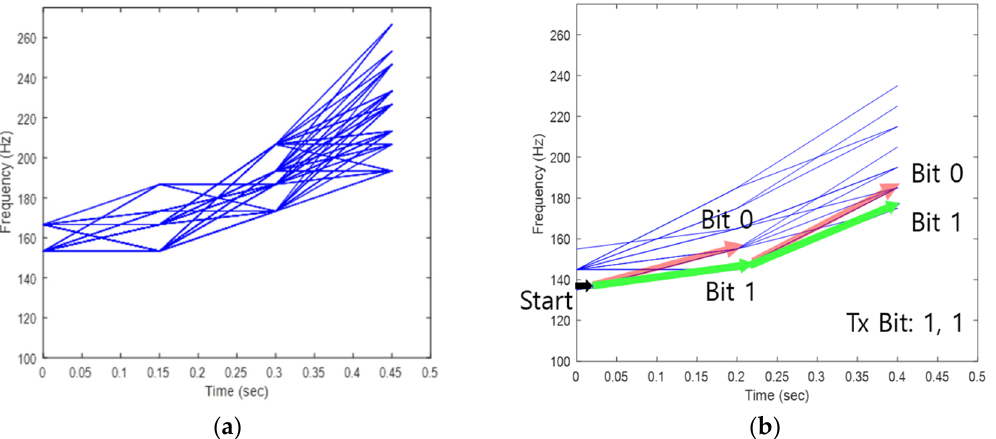
Figure 3. Modeling results of the time-dependent frequency change of the RHW whistle: ( a ) 0.4 s ≤ 𝑇 (cid:3050) ≤ 0.5 s, ∆𝑇 : 0.15 s, ∆𝐹 : 13.3 Hz and ( b ) 0.3 s ≤ 𝑇 (cid:3050) ≤ 0.5 s, ∆𝑇 : 0.2 s, ∆𝐹 : 10